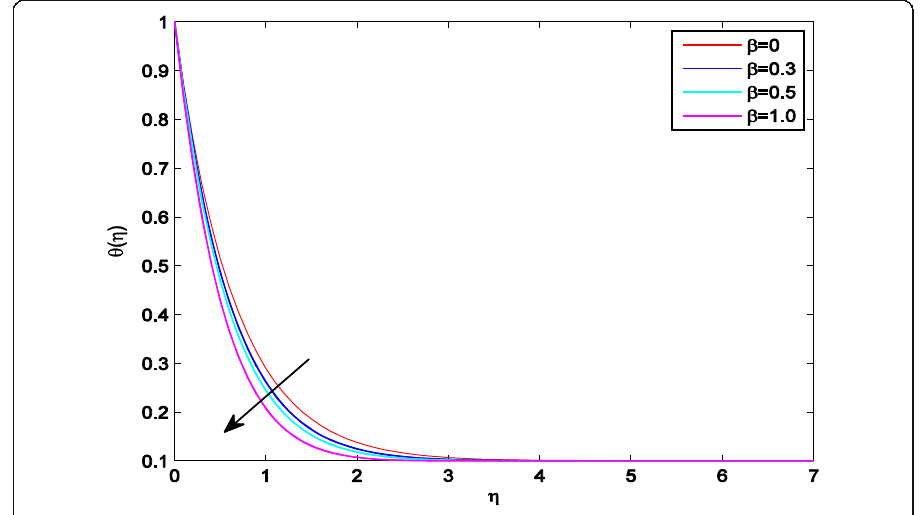
Fig. 18 Temperature graph for various values of